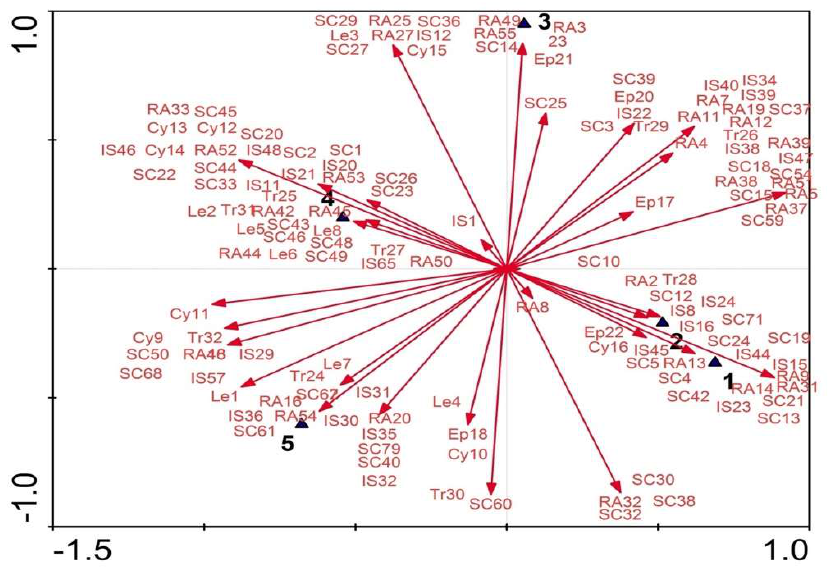
Figure 11. DCCA Triplot of the distribution of the studied taxa and their relationships to morpho- logical and molecular characters. Taxa: 1 − C. intybus var. intybus , 2 − C. intybus var. foliosum , 3 − C. endivia var. endivia , 4 − C. endivia var. crispum , 5 − C. endivia subsp. pumilum . Characters: Le − leaf, Cy − Cypsela, Ep − epidermal, Tr − trichome, SC − SCoT, RA − RAPD, and IS −